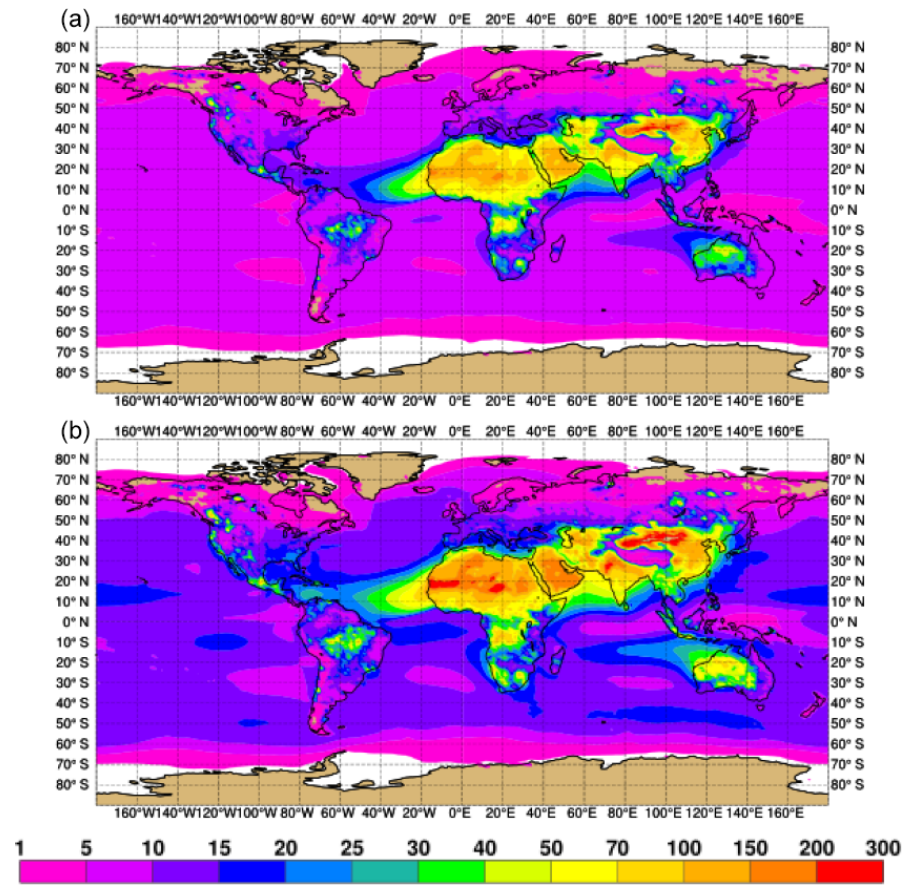
Figure 10. Global 2017 near-surface PM 2 . 5 (a) and PM 10 (b) (µgm − 3 ) simulated by IFS-AER cycle 45R1 in cycling forecast mode.